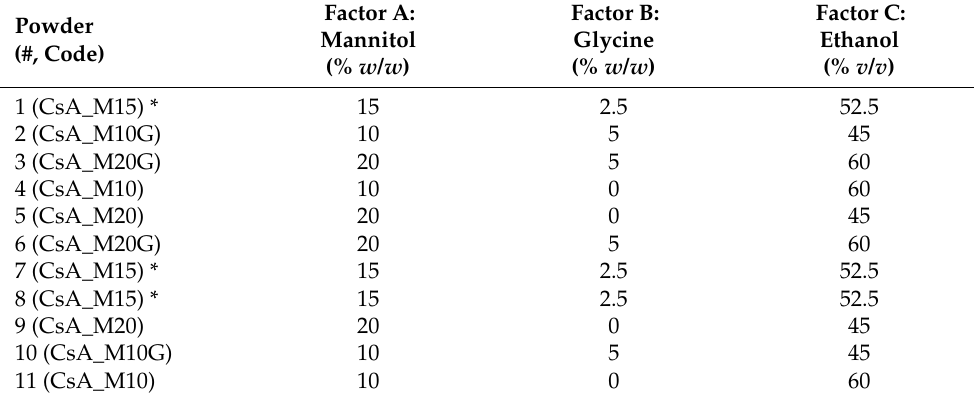
Table 1. Composition of powders studied according to the DOE with three factors at two levels and three centre points (*). M = mannitol; G = glycine. Each experimental point was replicated to calculate the experimental